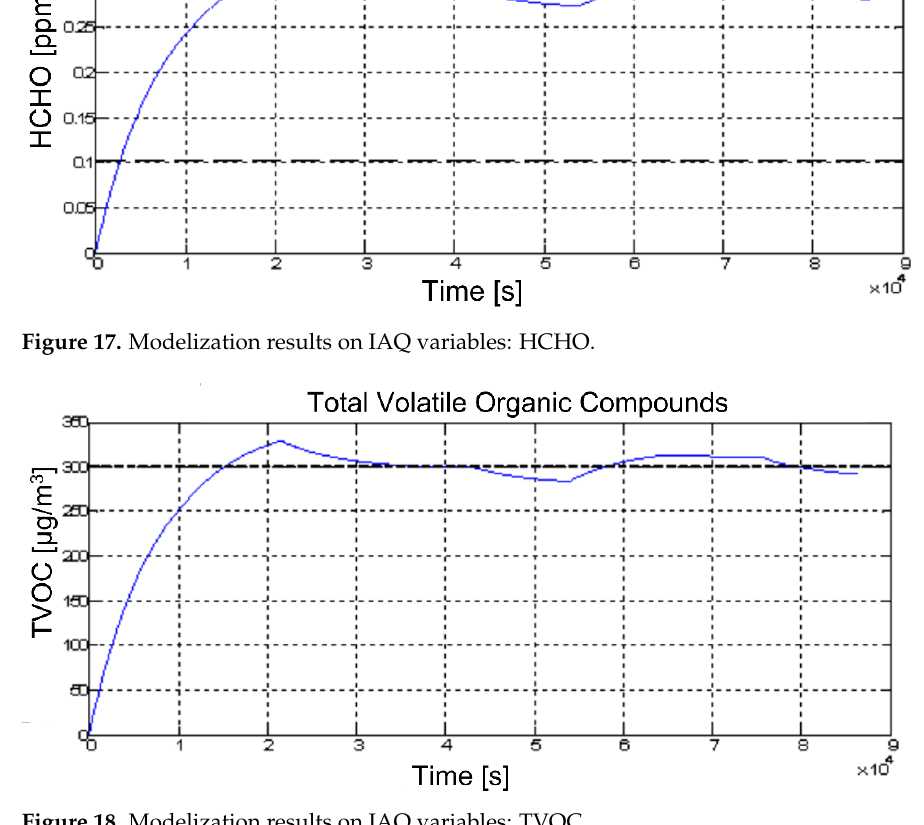
Figure 18. Modelization results on IAQ variables: TVOC.